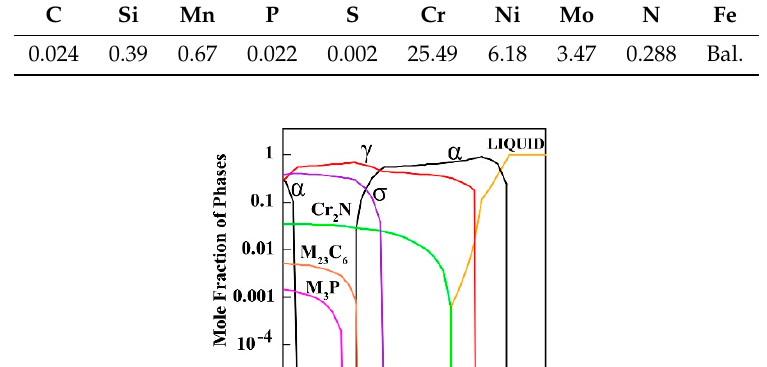
Table 1. Composition analysis of UNS S32750 super duplex stainless steel (mass fraction, wt%).